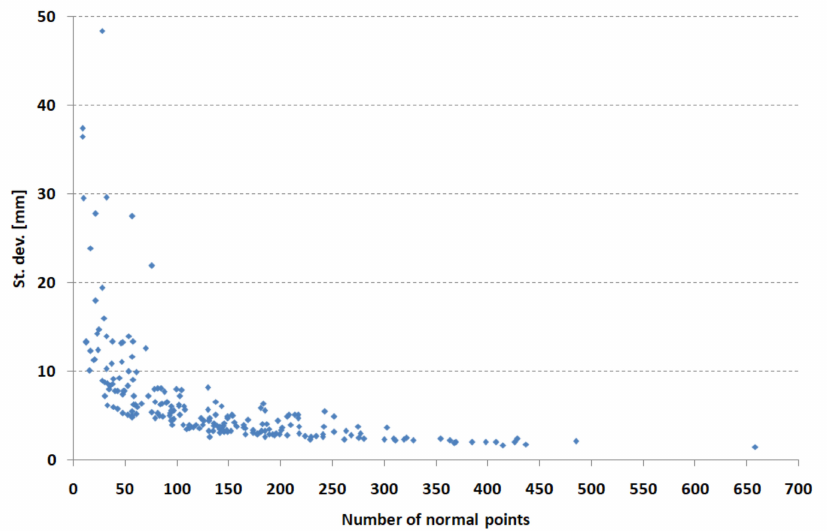
Figure 4. Dependence of the standard deviation of coordinate determination on the number of normal points for Borowiec SLR station.